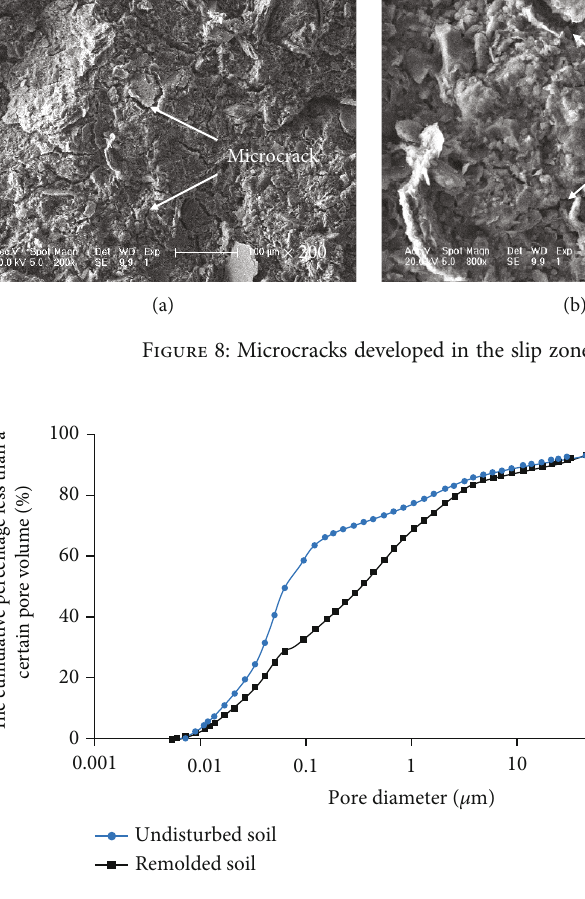
Figure 9: Pore distribution curves of undisturbed and remolded soil samples.